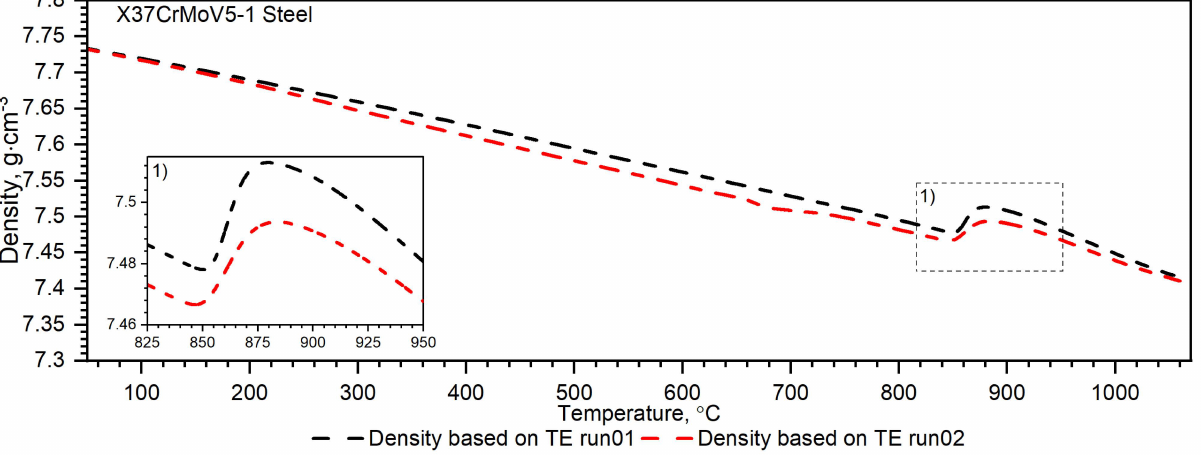
Figure 11. Density as a function of temperature for the X37CrMoV5 − 1 hot-work tool steel obtained from the first and second heating runs on DIL 402